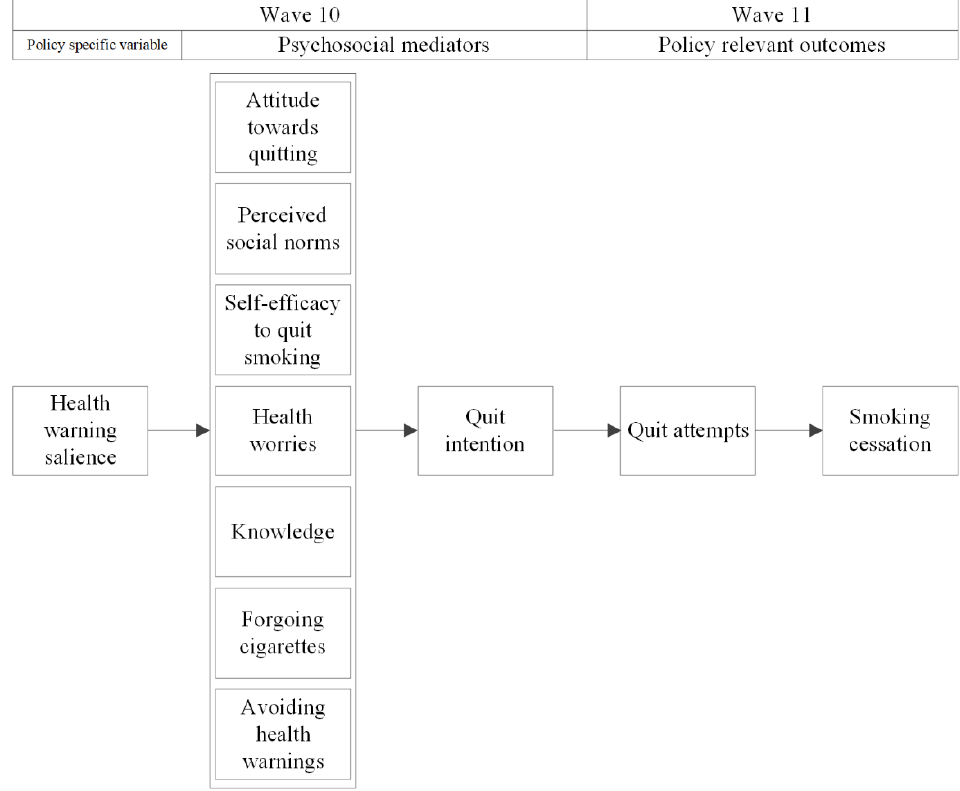
Figure 1. Hypothesized model of the mediational pathways through which the new EU tobacco health warnings on the packet of tobacco products may influence quit attempts and smoking cessation.